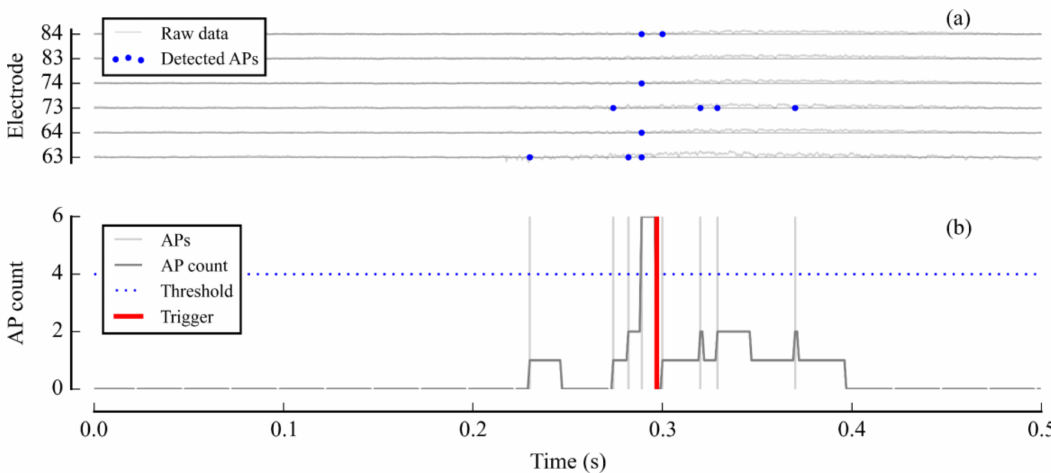
Figure 15. A stimulation command triggered by synchronized spiking activity in a neuron culture. The trigger was set off when more than four APs were detected across six selected channels in a 25 ms time window. ( a ) Unprocessed data on one of the channels of interest; ( b ) AP detection on the six channels of interest and, ( c ) Illustration of synchronization detection: AP count and related